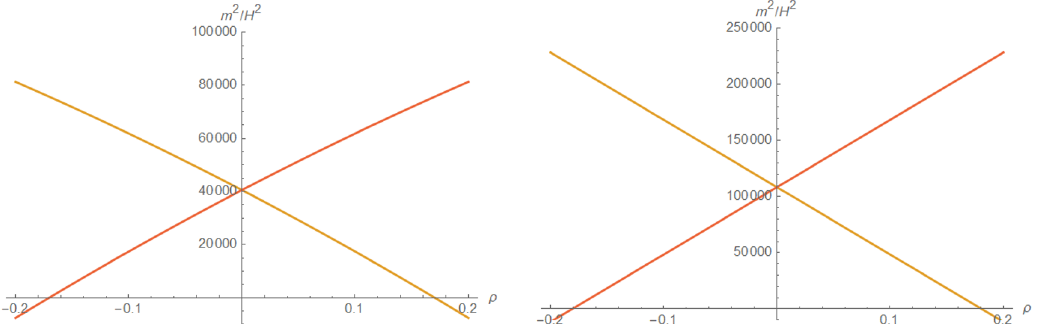
Figure 4 . The same as figure 3 but the quartic couplings in the frame function included. For both the R 2 -like inflation on left and the Higgs-like inflation on right, we took ( ζ s , ζ c ) = (3 , 0 . 4) , and the canonical inflaton field value as φ = 10